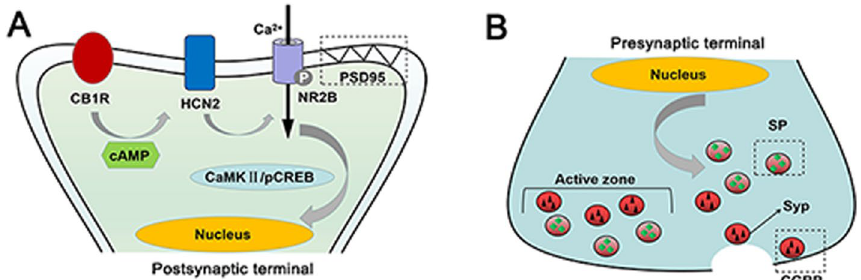
Fig. 12 Schematic diagrams of CB1R-mediated regulation on central sensitization. A In CM, activation of CB1 inhibits HCN2 activity by reducing cAMP levels, thereby suppressing the pNR2B/CaMKII/pCREB pathway. B A decrease in intranuclear pCREB level alleviates central sensitization by regulating expression levels of synaptic proteins (PSD95 and SYP) and nociceptive transmitters (SP and CGRP) in